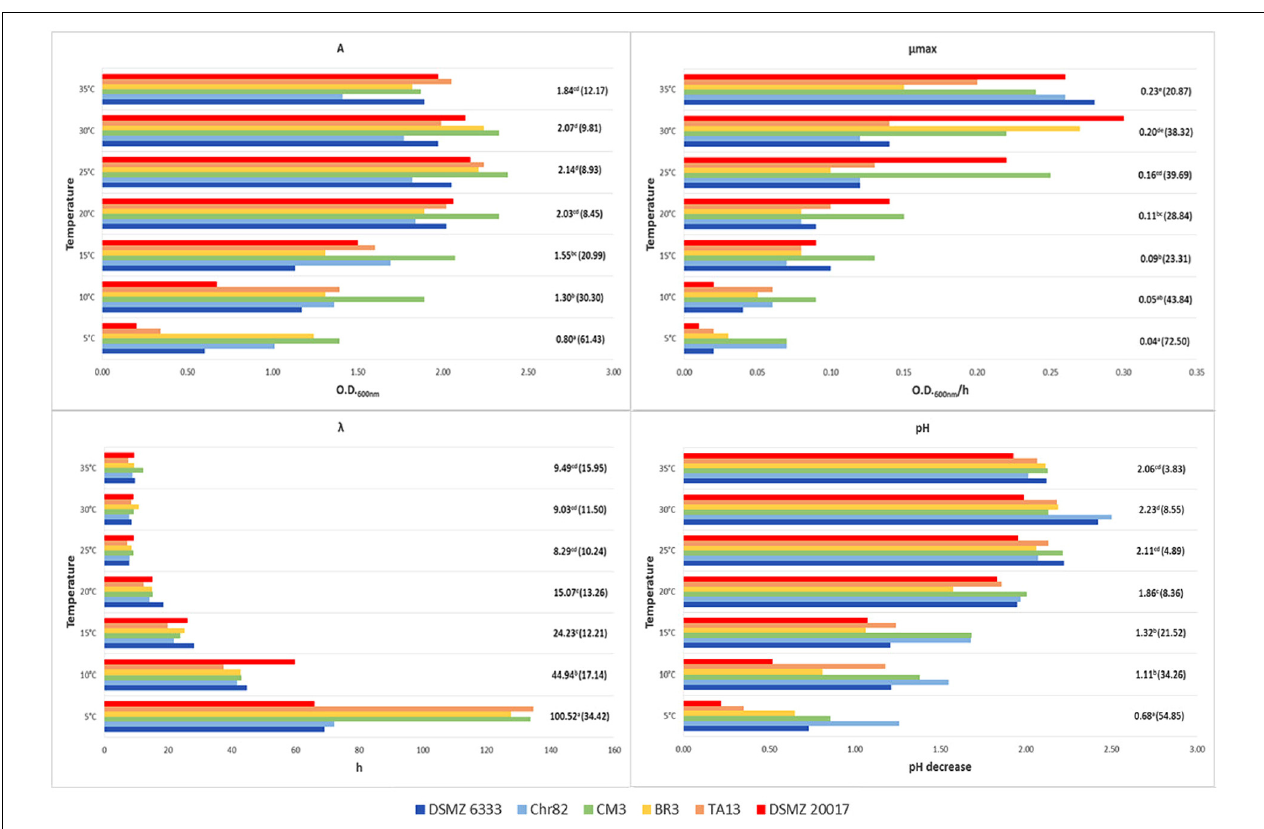
FIGURE 2 | Growth of L. sakei strains in MRS at different temperatures: estimates of the Gompertz parameters and pH decrease (initial value about 6.0). A represents the maximum OD 600 value reached, µ max is the maximum OD 600 increase rate in exponential phase and λ is the lag time. For each temperature, the mean value is reported and the relative coefficient of variation is indicated between brackets. Means with the same letter are not statistically different ( P > 0.05) according to the post hoc (LSD test) comparison of